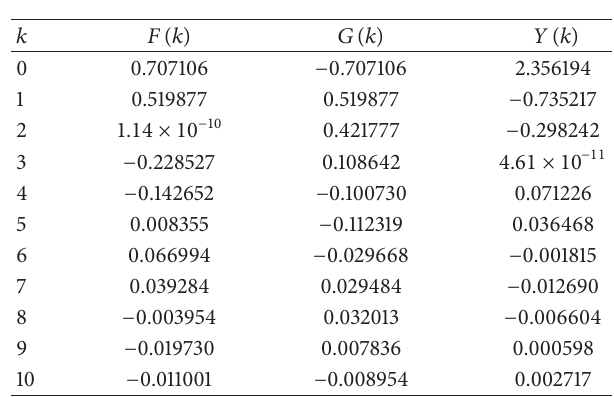
Table 6: 𝐹(𝑘) and 𝑌(𝑘) values in Example 3 for 𝛼 = 0.9 , 𝑡 = 0.05 , and 𝑘 ≤ 10 .